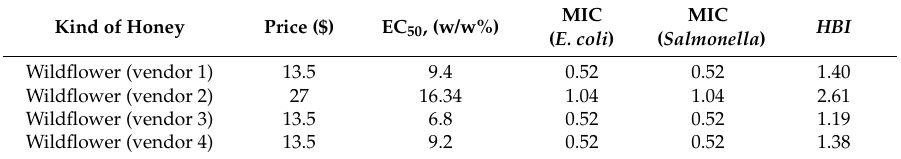
Table 4. Commercial Israeli honey types, prices, and antioxidant and antimicrobial activity. Kind of Honey